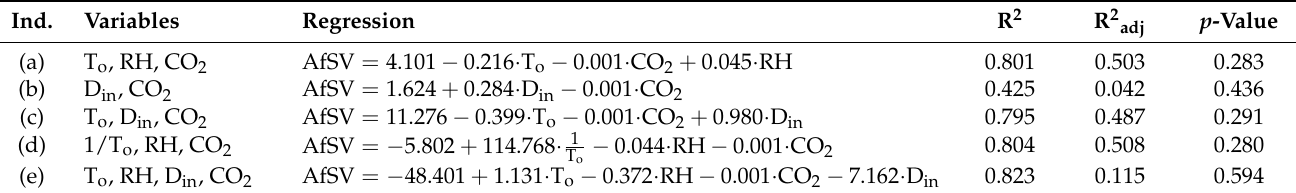
Table 10. The outcomes of the multiple regression analysis between AfSV and internal conditions.